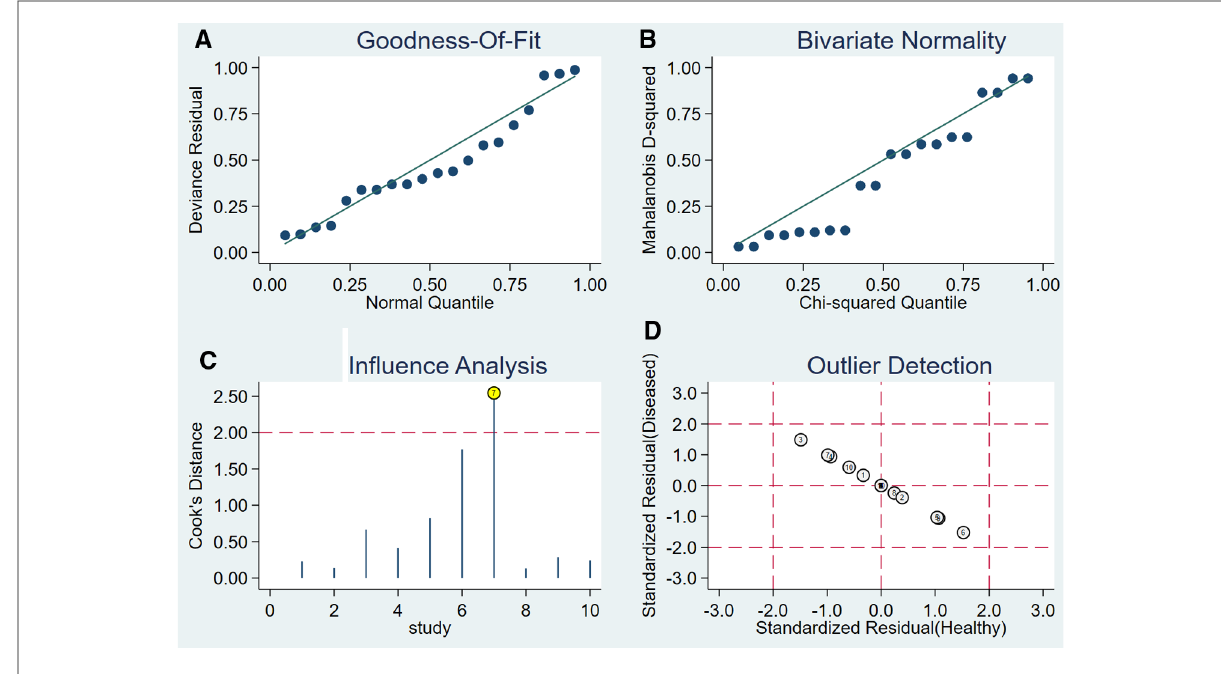
Figure 8 The sensitivity analysis of CT.